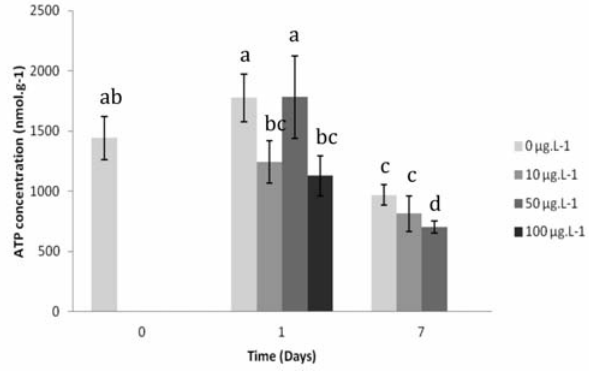
Figure 4. ATP concentration in white muscle of roach exposed to copper. Different letters indicate significant differences